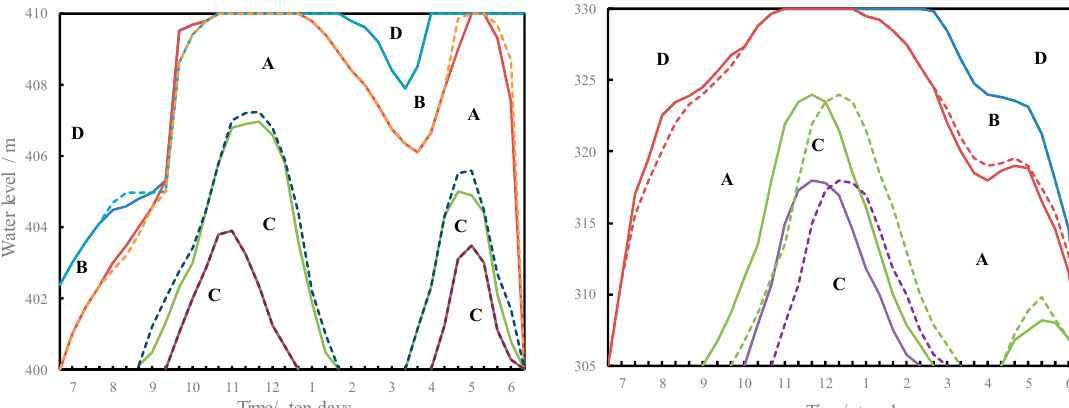
Chart 2: Modified optimal single reservoir operation charts